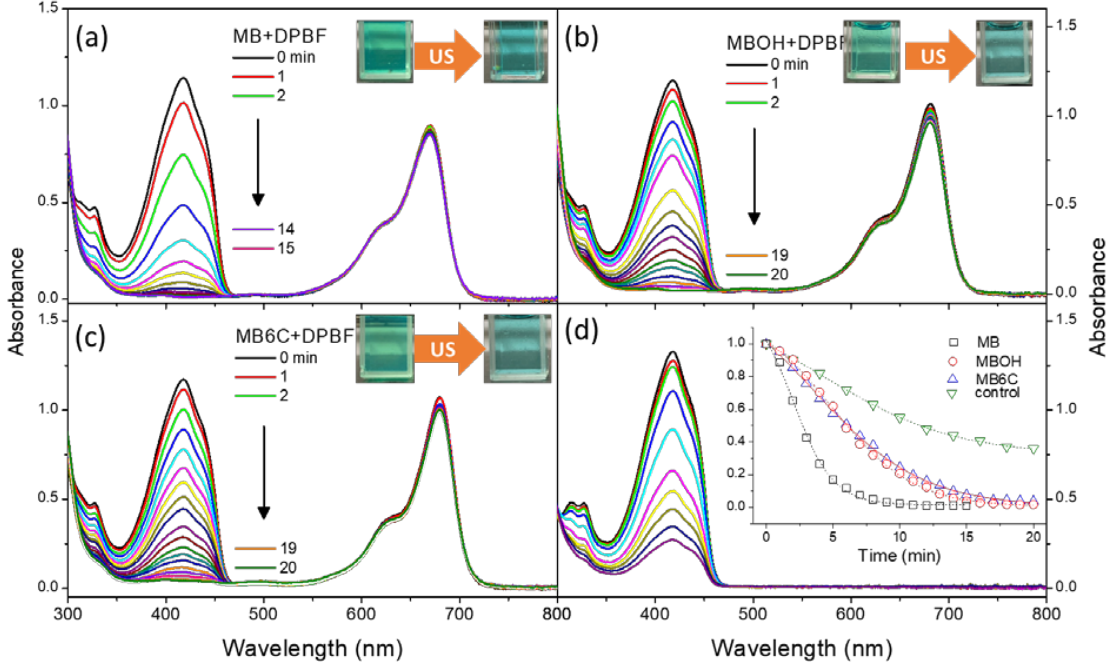
Figure 5. Absorption spectra variations of DPBF mixing ( a ) MB, ( b ) MBOH, and ( c ) MB6C in DMSO under an ultrasound environment. The control experiment without adding a compound is shown in ( d ), and the insert shows the comparison of DPBF oxidation rates by the singlet oxygens of the above experimental results.